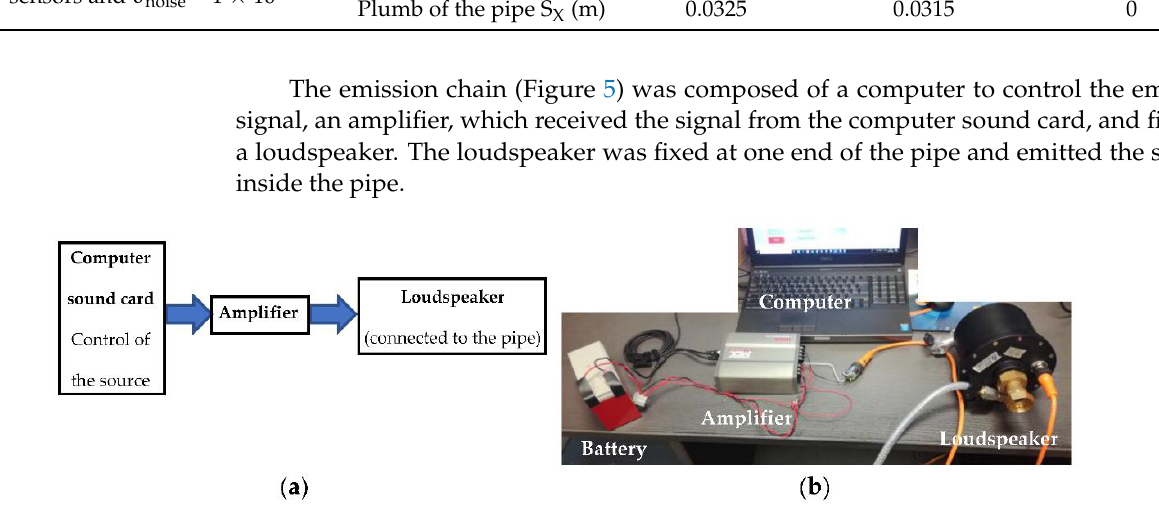
Figure 5. Experimental set-up of the acoustic emission chain: ( a ) diagram of the main components; ( b ) photograph of the material with the battery to power the amplifier.